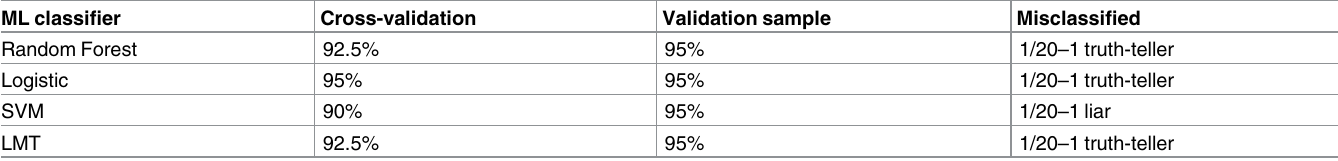
Table 4. Classification accuracyin the 10-fold cross-validation and in the validation sample.